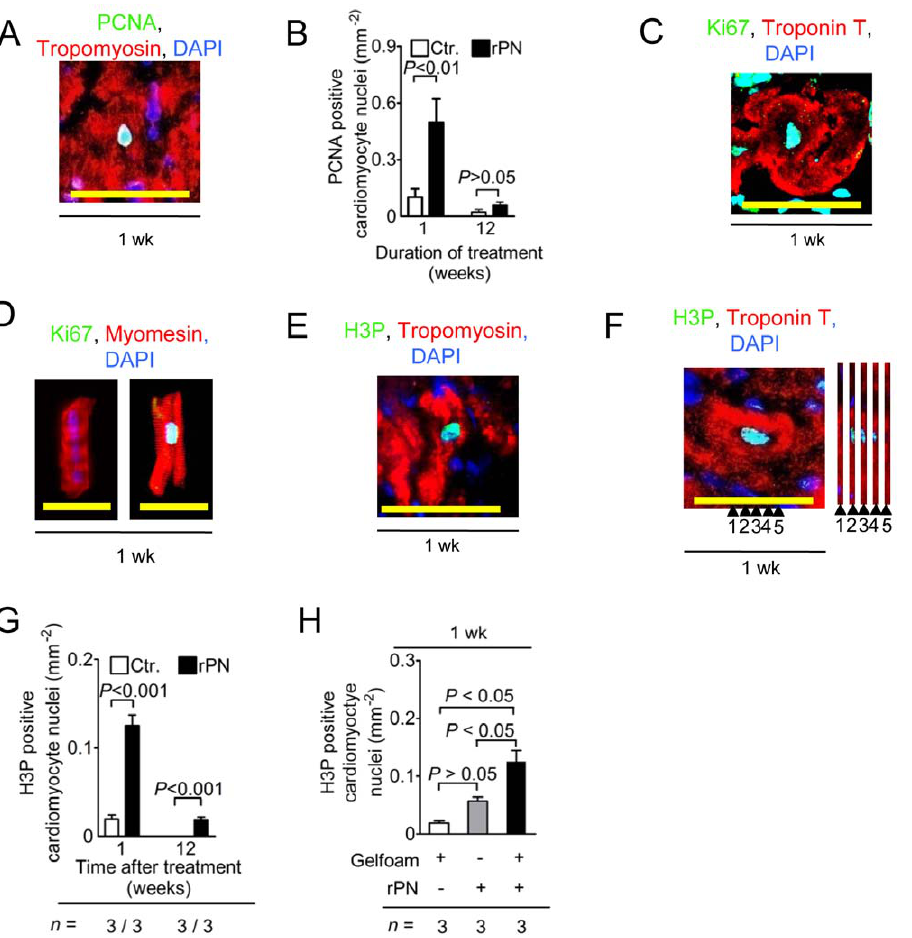
Figure 6. Gelfoam loaded with rPN increases cardiomyocyte cell cycle activity after MI. (A–D) Visualization and quantification of cell cycle activity in tissue sections and in isolated cardiomyocytes from animals treated with rPN, respectively. (E–F) Determination of cardiomyocyte mitosis by visualization of H3P positive cardiomyocyte nuclei. A series of yz reconstructions is shown to the right of the micrograph. (G) Quantification of cardiomyocyte mitosis after 1 wk and 12 wks of treatment. (H) Quantification of the effect of administering rPN adsorbed onto Gelfoam versus administration of rPN alone on cardiomyocyte mitosis. H3P, phosphorylated histone H3 (S10); Ctr, hearts receiving Gelfoam with PBS; rPN, hearts receiving Gelfoam with periostin peptide; n is the number of animals per group. Scale bars, 100 m m.